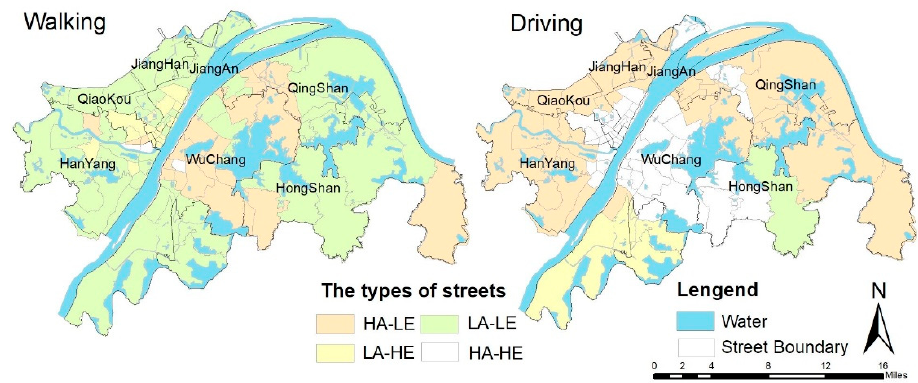
Figure 8. Street distribution of three types by walking and driving.